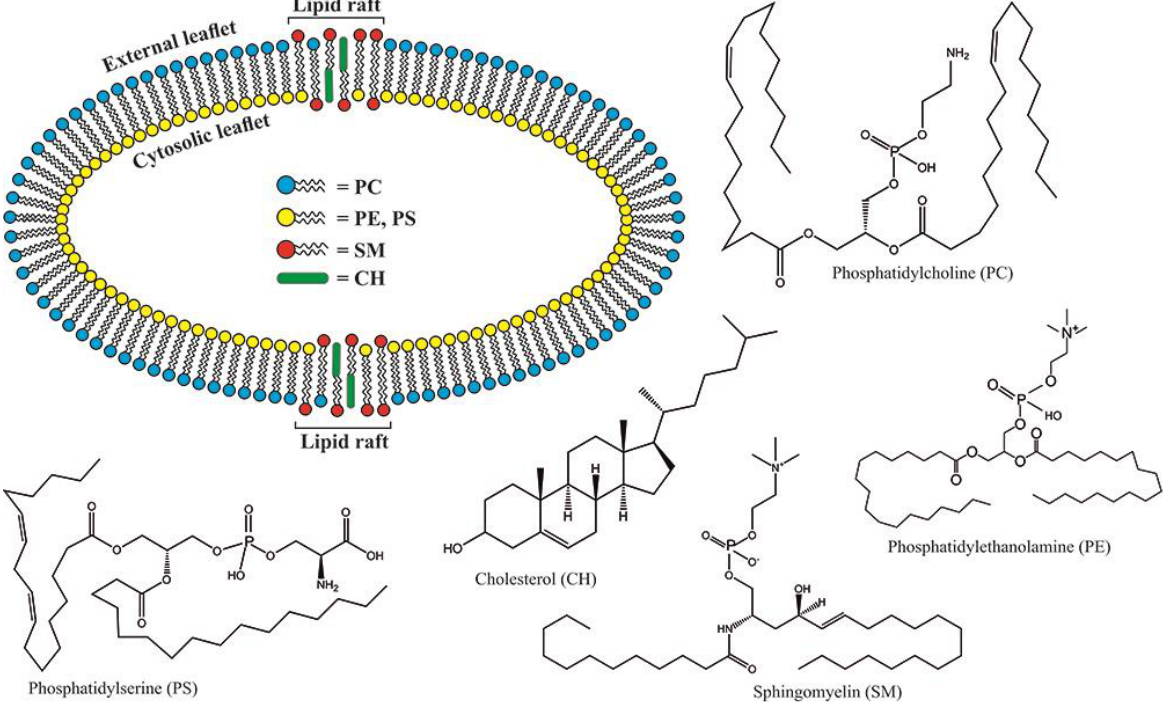
Figure 1. Lipid profile of platelet plasma membrane: PC—DL-a-Phosphatidylcholine, distearoyl; PE—1,2-dioleoyl-sn-glycerophosphoethanolamine; PS—1-oleoyl-2-palmitoyl-sn-glycero-3-phospho-L-serine; SM—N-Lauroyl-D-erythro-sphingosylphosphorylcholine; CH—cholesterol.